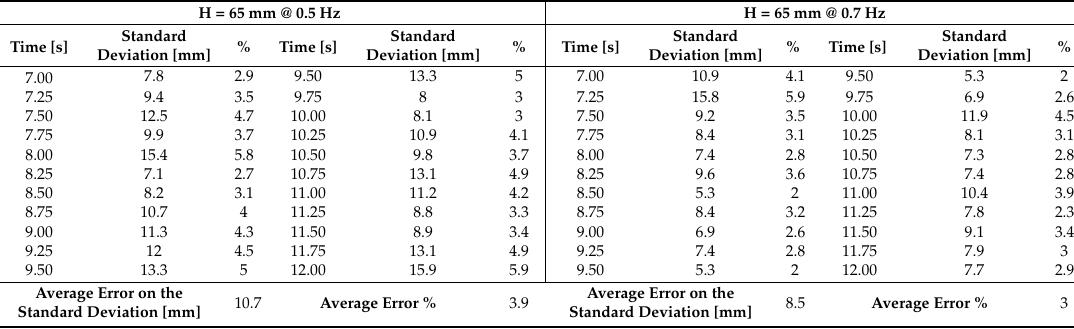
Table 3. Model output for the free surface ( Test 1